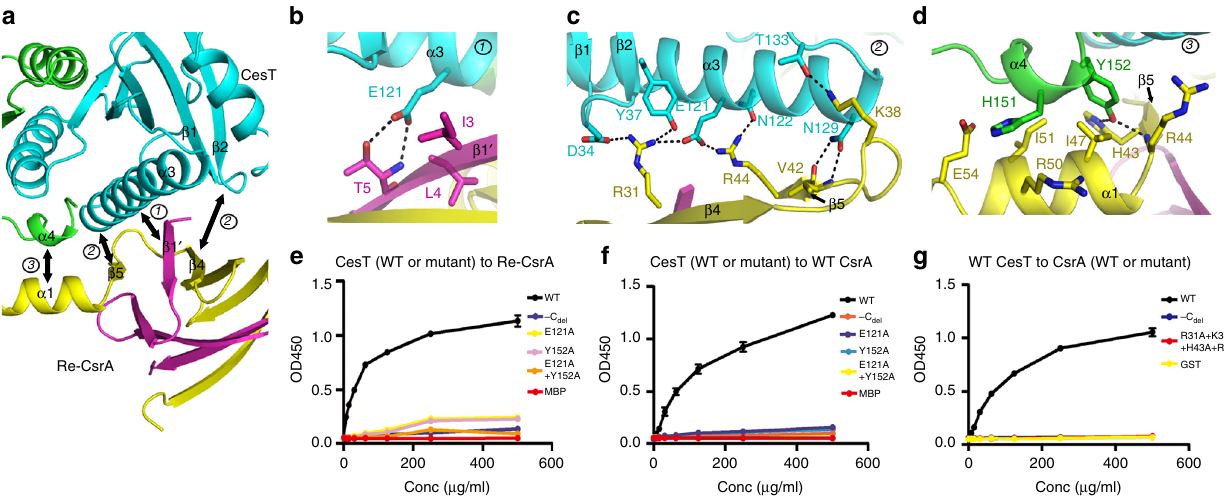
Fig. 4 The atomic binding details between CesT and Re-CsrA. a An overview of the binding interface. Based on the protomer-af fi liations (to either the parental molecule of the dimer or the second protomer) of the engaging components, the inter-molecule CesT/CsrA interactions are allocated to three binding patches which are further illustrated in b – d for amino acid interaction details. b Interactions contributed by the second CsrA protomer contacting the parental CesT molecule. c Interactions contributed by both the CsrA and CesT parental molecules. d Interactions contributed by the parental CsrA contacting the second CesT protomer. The engaging components and the interface residues are shown and labeled. Dashed lines indicate hydrogen bonds or salt bridges. e – g An ELISA assay verifying the roles of the identi fi ed key interface residues in CesT/CsrA interactions. Serial dilutions of the indicated CesT (WT or mutant) proteins were tested for their binding to immobilized CsrA or Re-CsrA (WT or mutant) proteins. The recorded absorbance at 450 nm is plotted and shown. All the results are expressed as means ± standard deviations (SD) from three independent experiments. e Binding of WT or mutant CesT to Re-CsrA. f Binding of WT or mutant CesT to native CsrA. g Binding of WT CesT to CsrA of WT or mutant α 4 helix, thereby preparing it for contacts with CsrA (see Results below).